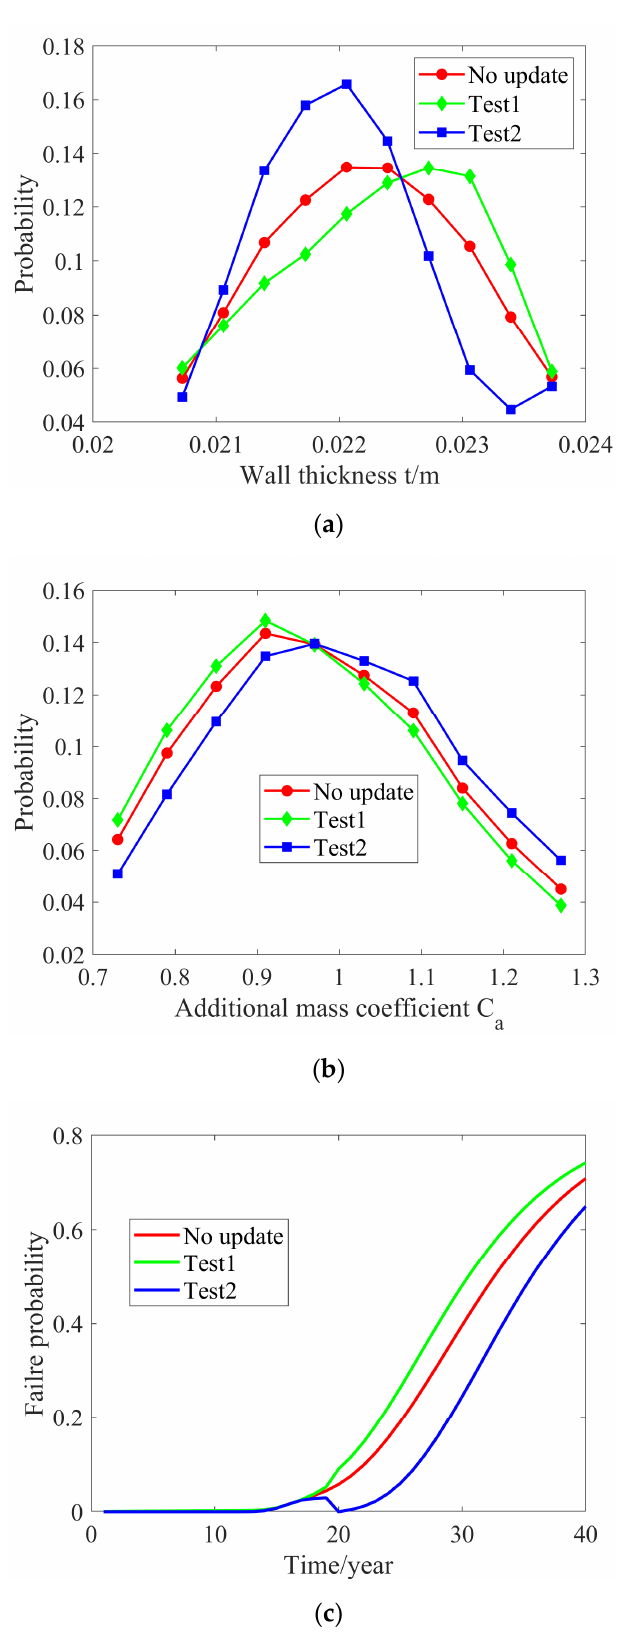
Figure 17. Parameter updating in the 20th year. ( a ) Updated t , ( c ) Updated failure probability, ( b ) Updated C a.